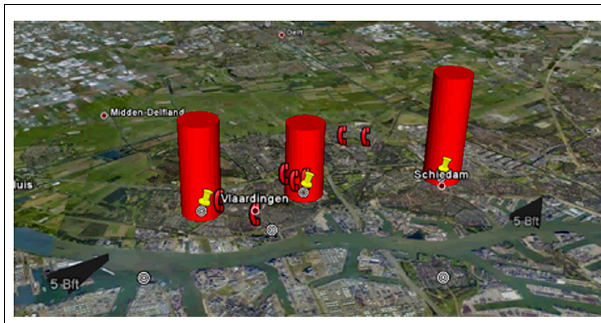
FIGURE 1 | Odor signatures in the harbor of Rotterdam. The odor signature disseminates in the direction of the wind leading to increased complaints of inhabitants (telephone symbols on the figure), with permission of Simon